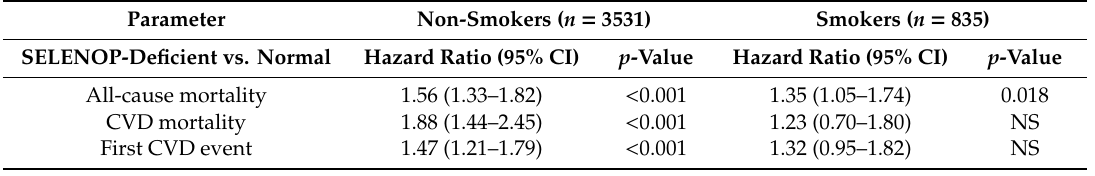
Table 3. Association of SELENOP status in relation to major endpoints in non-smokers vs. smokers. Parameter Non-Smokers ( n = 3531) Smokers ( n = 835) SELENOP-Deficient vs. Normal Hazard Ratio (95%